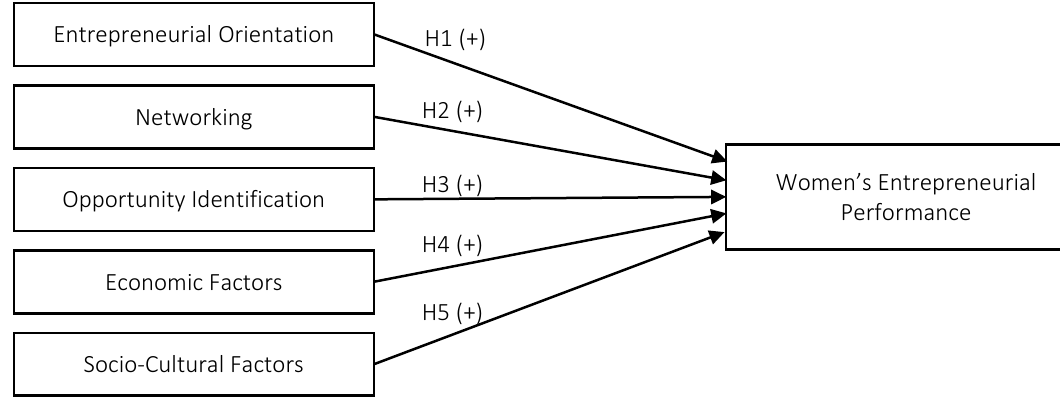
Figure 1. Theoretical